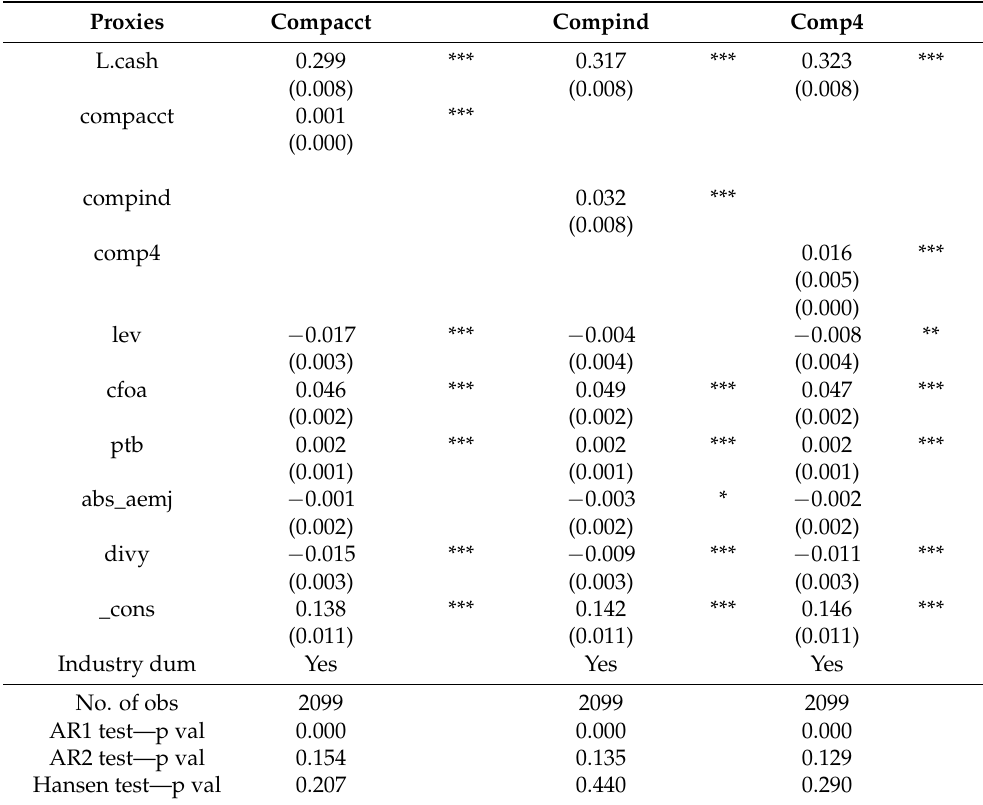
Table 3. Impact of comparability on cash